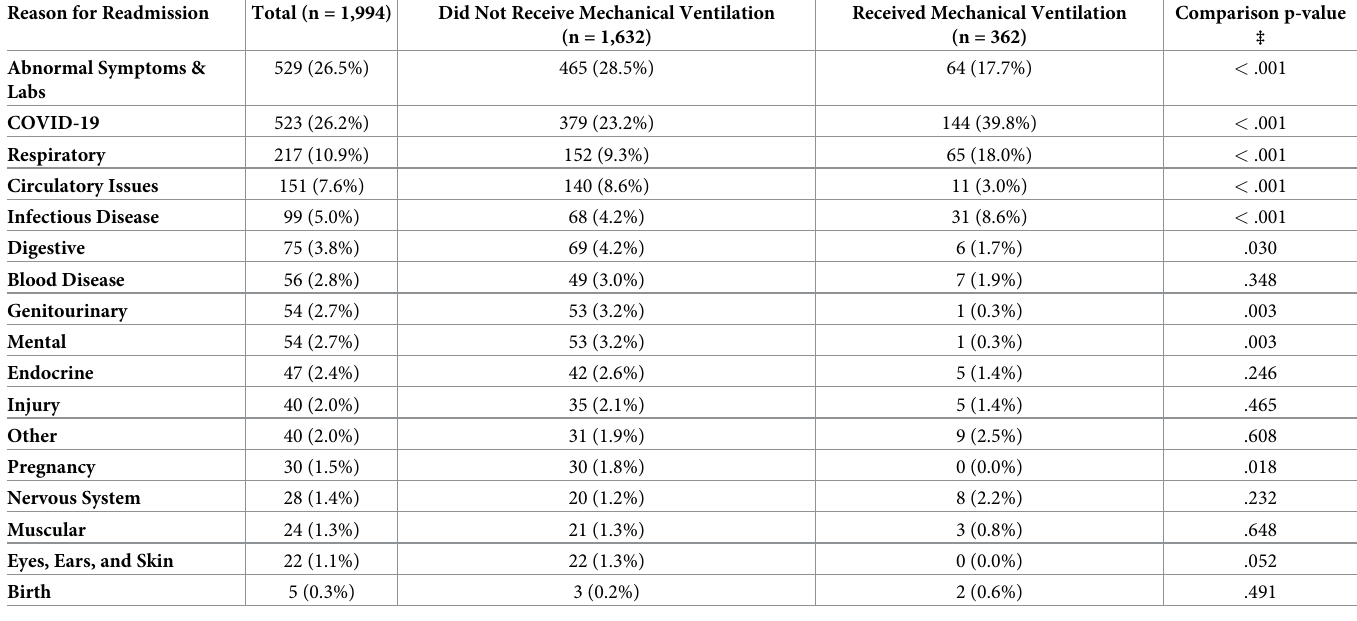
The multinomial logistic regression showed that individuals who received MV (compared to individuals who did not receive MV) had greater odds of being readmitted to inpatient care for COVID-19, infectious diseases, or respiratory issues relative to other diagnoses. These Table 3. Reasons for readmission by mechanical ventilation treatment